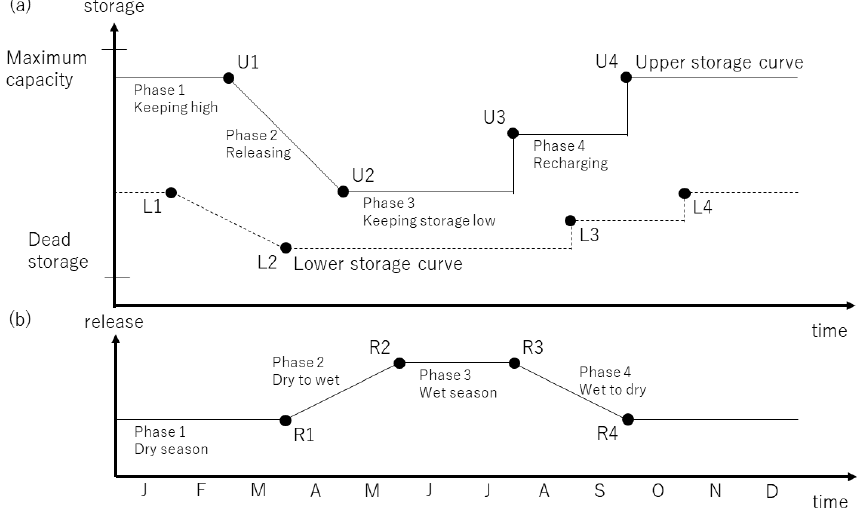
Figure 2. Schematic diagrams of (a) the upper and lower storage curves and (b) the release curve.